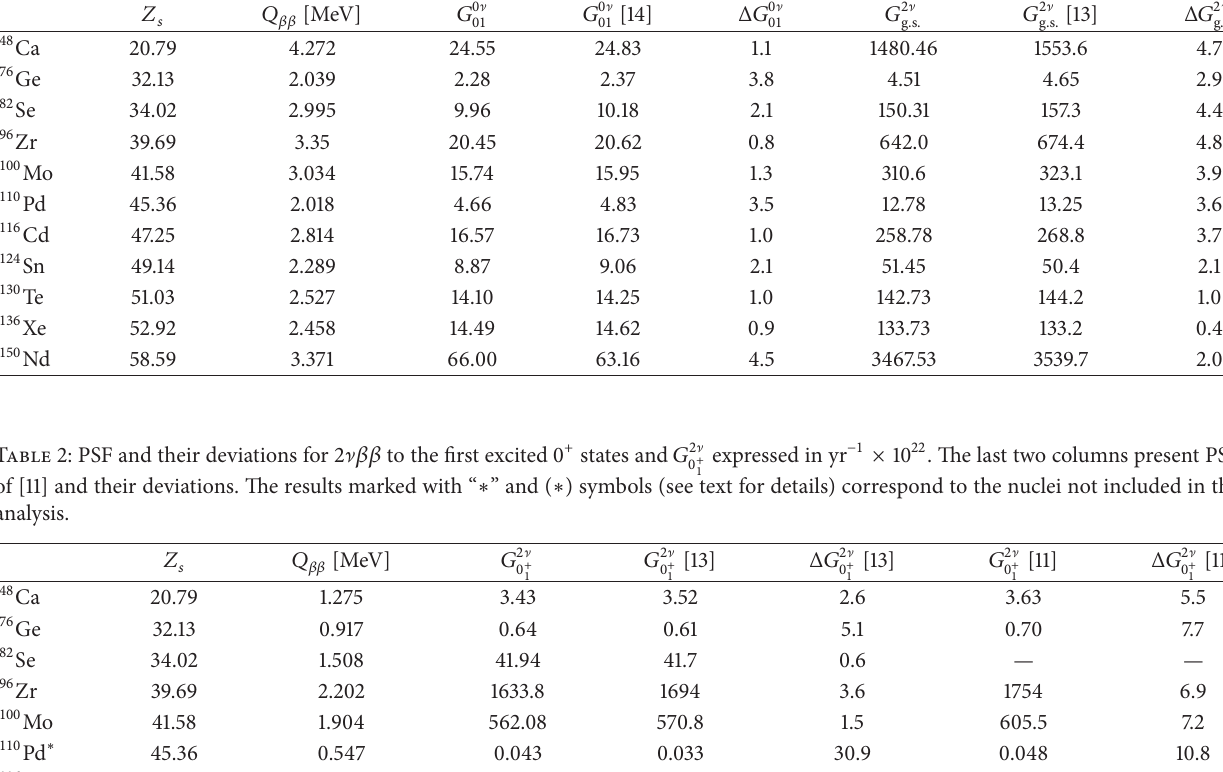
Table 1: 0 ] 𝛽𝛽 to ground states PSF 𝐺 0 ] 01 expressed in yr −1 × 10 15 and 2 ] 𝛽𝛽 to ground states 𝐺 2 ] with the optimal “screening factor” for 𝑠 -PSF, 𝑆 𝑓 = 94.5 , and compared to those of [14] for 0 ] 𝛽𝛽 and [13] for 2 ] 𝛽𝛽 . Second and third columns display the effective screened charge, 𝑍 𝑠 , of the daughter nucleus and the energy of the decay, 𝑄 𝛽𝛽 .